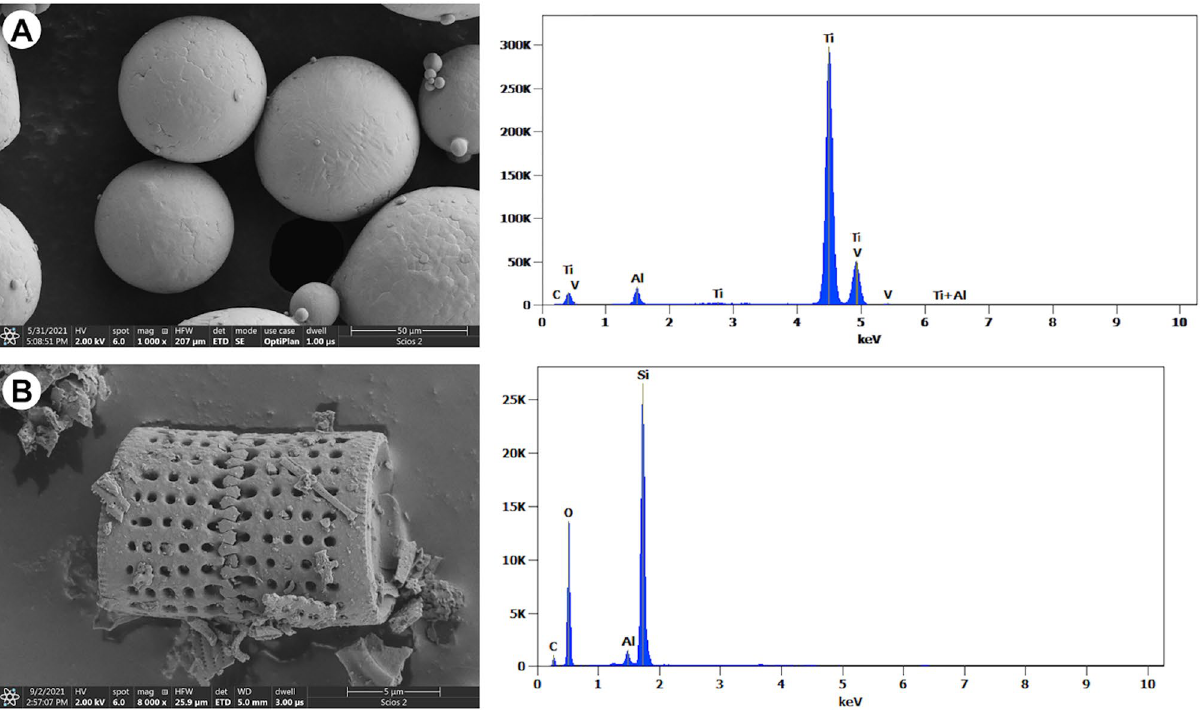
Figure 1. SEM–EDS morphologies of as-received ( a ) Ti6Al4V particles and ( b ) diatomaceous earth